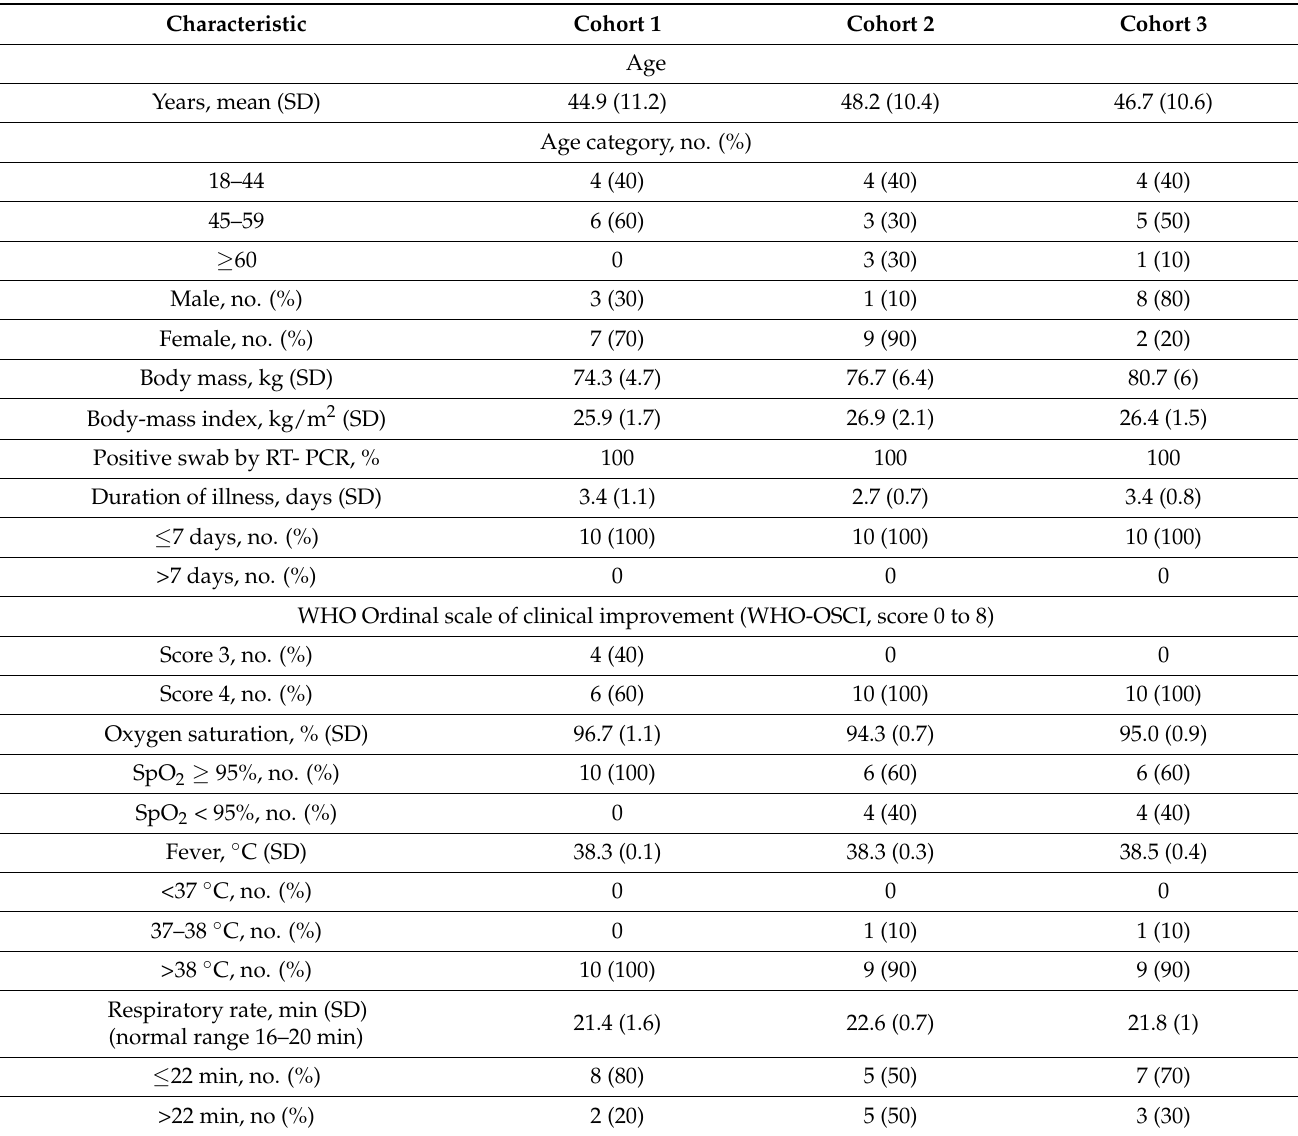
Table A1. Demographic and baseline characteristics of the